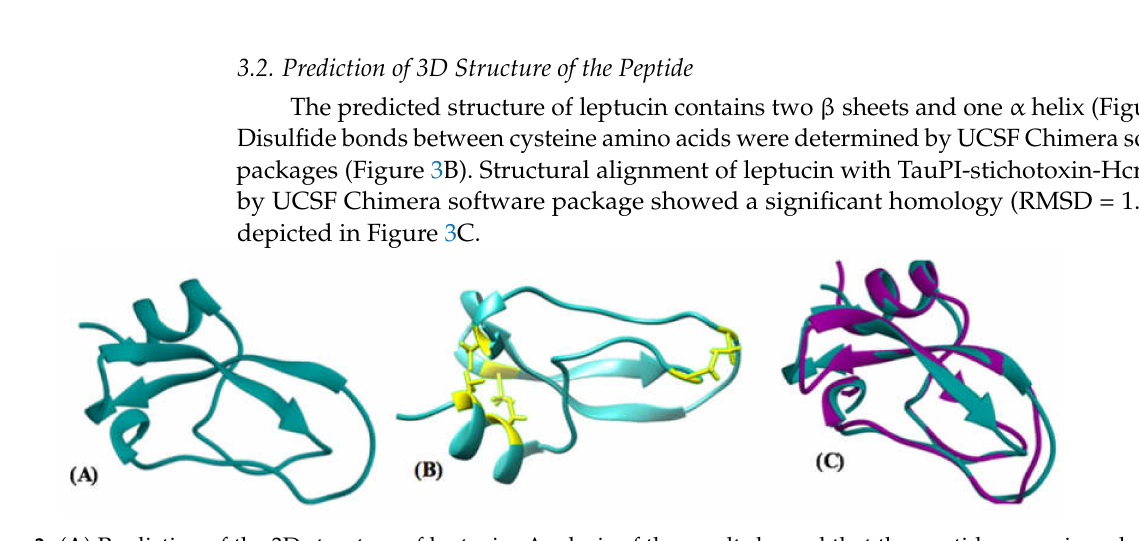
Figure 3. ( A ) Prediction of the 3D structure of leptucin. Analysis of the result showed that the peptide comprises alpha helices (25.45%), beta sheets (25.45%), and random coil (49.09%). ( B ) Based on 3D structure, disulfide bonds between cysteine amino acids were predicted in leptucin as C 1 -C 6 *C 2 -C 4 *C 3 -C 5 . ( C ) Superimposition of the structure of TauPI- stichotoxin-Hcr2b with the predicted structure of leptucin.